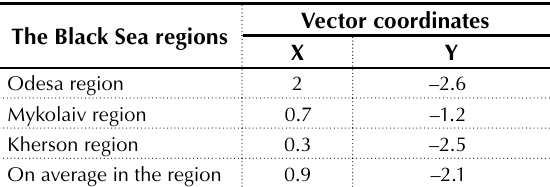
Table 4. Calculating the vector of the strategic position of the Black Sea regions Source: Calculated by the authors.